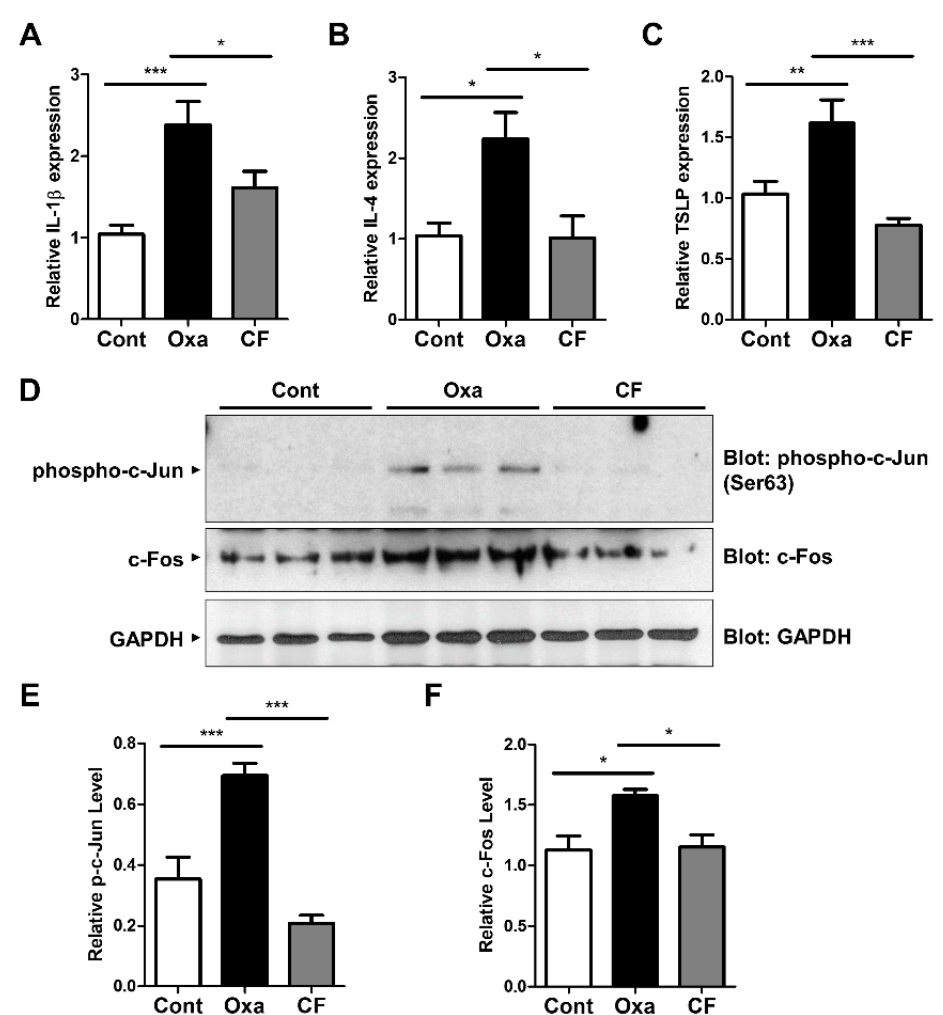
Figure 5. The immunosuppressive effect of CF on AD skin tissues. ( A – C ) IL-1 β , IL-4, and TSLP mRNA expression levels in skin tissues were measured by qRT-PCR. ( D – F ) Western blot analysis was performed with three mice from each group with the indicated antibodies ( D ), and then quantified ( E , F ). * p < 0.05; ** p < 0.01; *** p < 0.001.